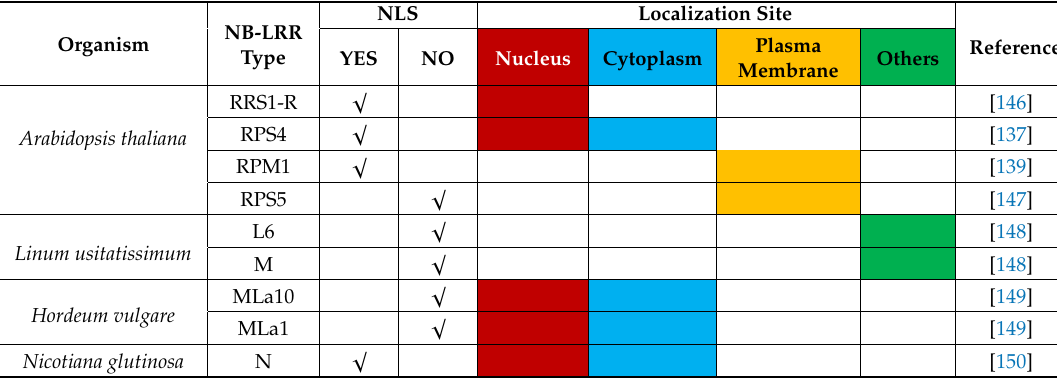
Table 3. Many NB-LRRs were predicted with and without NLS. Irrespective of presence of a definite NLS, some NB-LRRs have their subcellular localization in nucleus and di ff erent